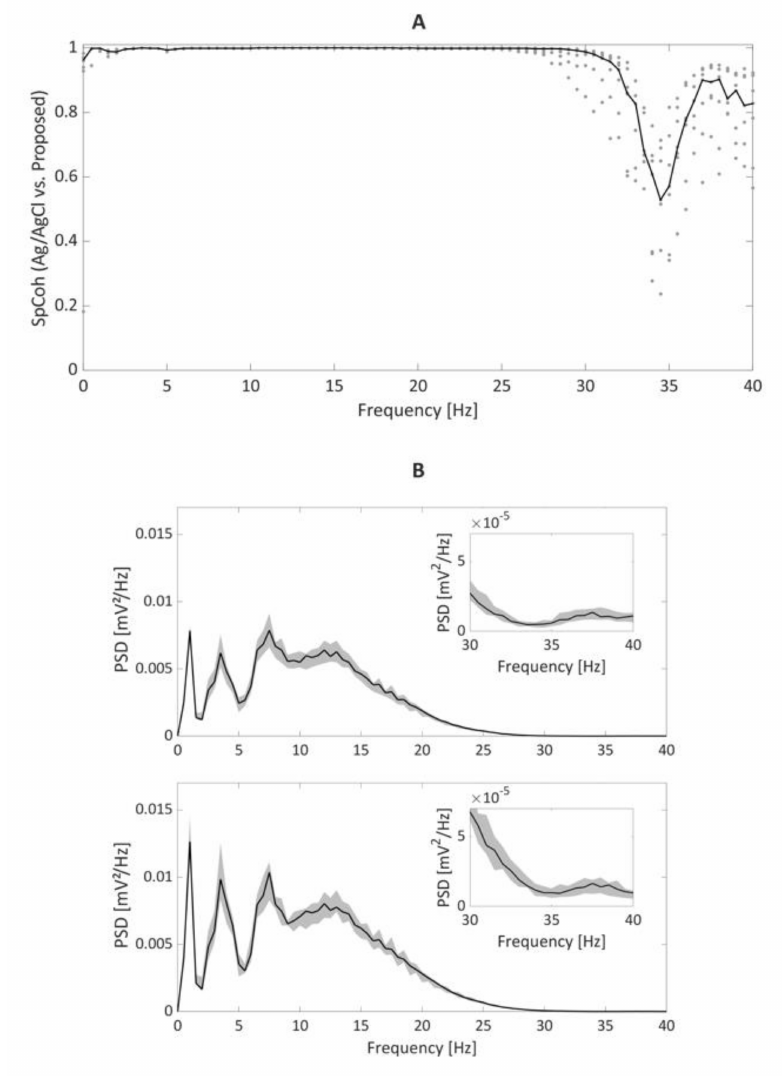
Figure 6. SpCoh results ( A ) for the comparison of the recording obtained by gelled Ag/AgCl and ferrimagnetic-conductive epidermal electrodes recordings (( A ), on the left). Black line represents the median values of SpCoh across frequencies, whereas grey dots represent the values assumed in the different recording sessions. In ( B ), the median PSD trends (in black) with their 5th and 95th percentiles (grey shading) are depicted for the recordings with Ag/AgCl (top) and the proposed ferrimagnetic-conductive epidermal electrodes (bottom), along with an enlarged depiction of the 30–40 Hz